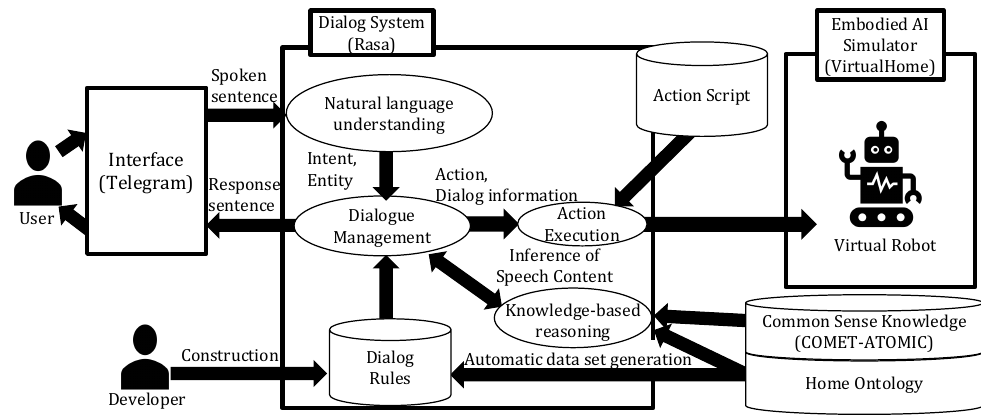
Figure 2. System configuration diagram.